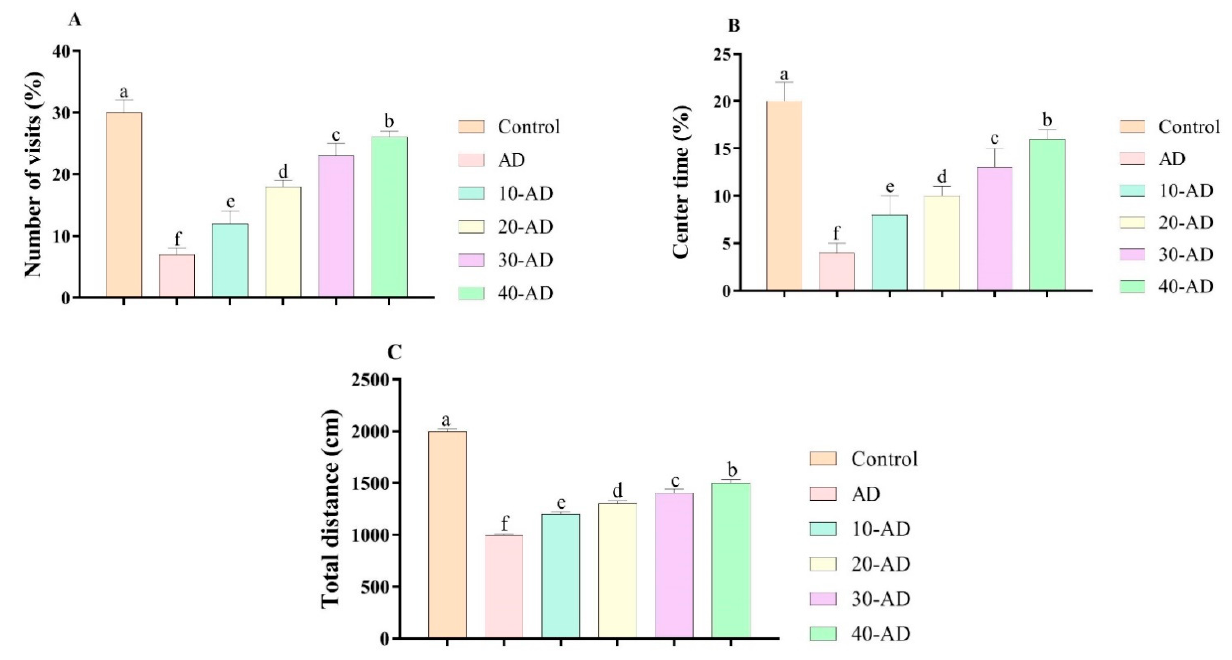
Figure 1. The effects of sake yeast on anxiety-like behaviors in rats with Alzheimer. (A) Number of visits; (B) Center time and (C) total distance. Different superscript symbols (a–f) show significant differences between groups at p < 0.05.